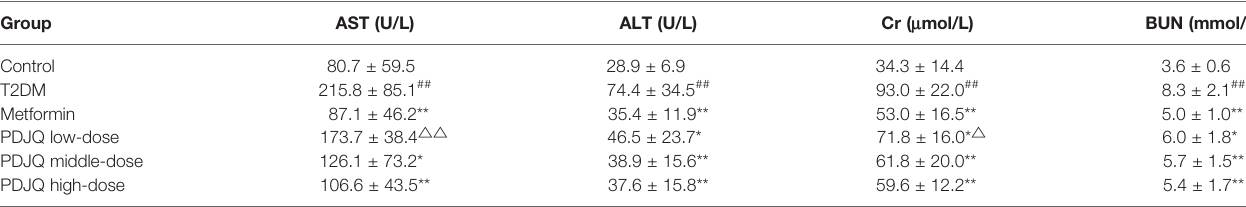
TABLE 2 | Changes in serum AST, ALT activities and serum Cr, BUN levels after PDJQ treatment. Group AST (U/L)